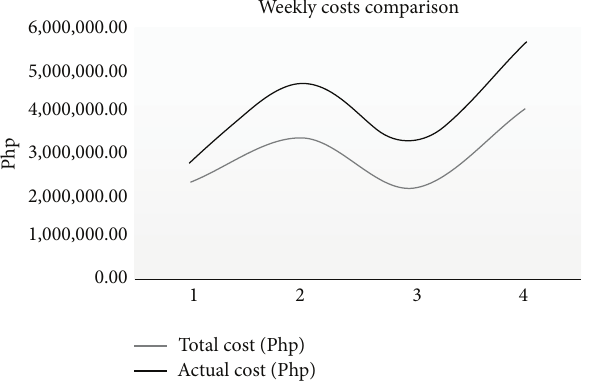
Figure 7: Weekly costs